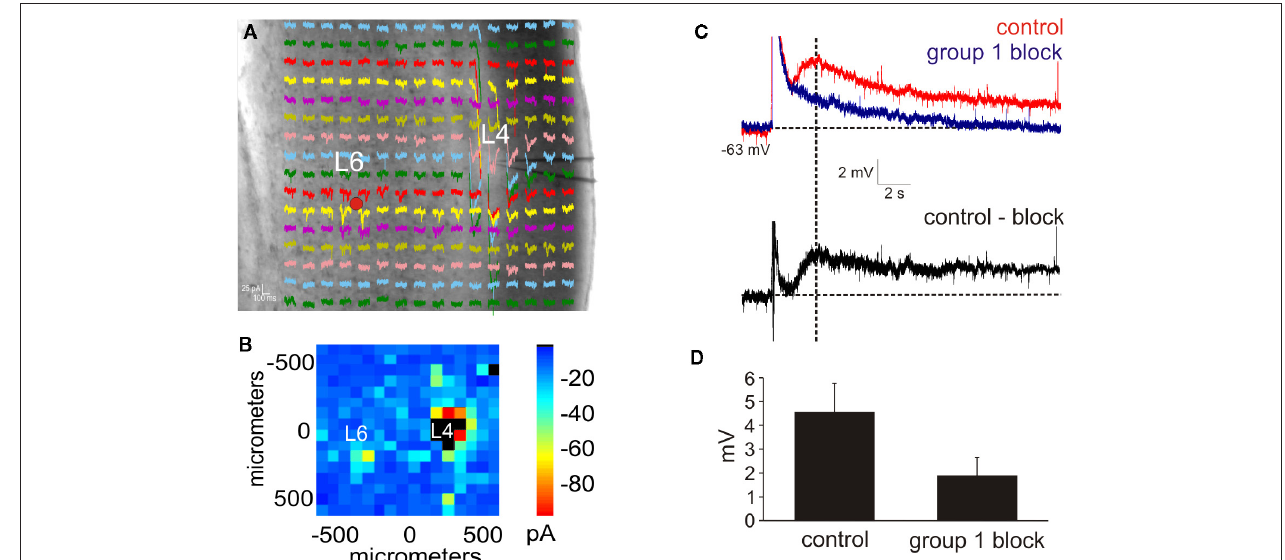
followed by a slow depolarizing response (red trace). Blocking the group 1 FIGURE 2 | Photostimulation of the layer 6 input to layer 4. (A,B ) metabotropic glutamate receptors abolishes the slow depolarizing response, Photostimulation with caged glutamate in the cortex (AII) identifi es the leaving the AMPA mediated response (blue trace). The group 1 mGluR response location of layer 6 input to layer 4. (A) Whole-cell, voltage clamp recordings is observed in a subtracted trace (control-block: black trace). Baselines denoted from layer 4 (L4) in response to photostimulation at 256 separate cortical loci by horizontal dashed lines. Amplitudes were measured at the peak time (colored traces). (B) Response map plot illustrating the peak EPSC denoted by the vertical dash line. (D) In the presence of group 1 mGluR amplitude within 100 ms of the stimulus onset. (C) After pharmacologically antagonists, the amplitude of the depolarizing response is signifi cantly reduced blocking receptors for GABA , GABA , group 2 mGluR, and NMDA and A B ( p < 0.05, t photostimulating in layer 6 (red dot in A), a large AMPA response is elicited